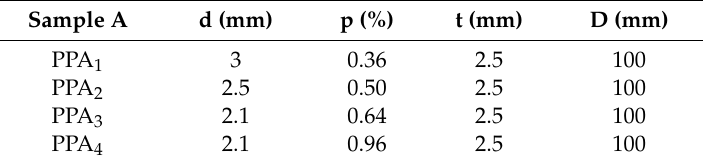
Table 3. Parameters of the four parallel-arranged PPAs for 120–250 Hz.